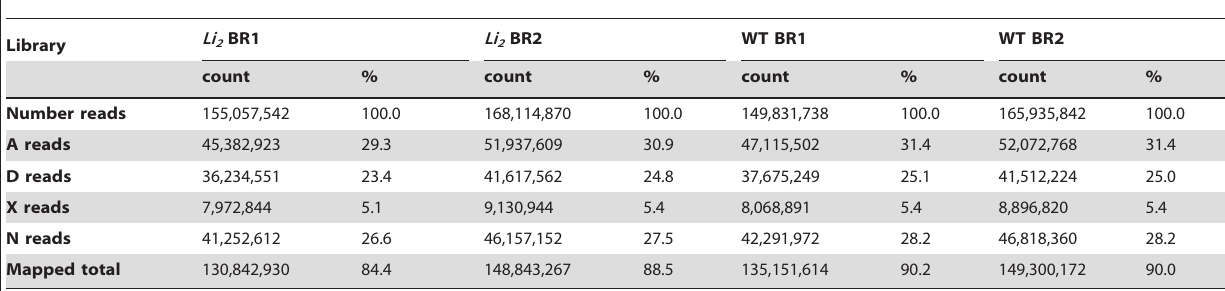
Table 1. Results of mapping reads.